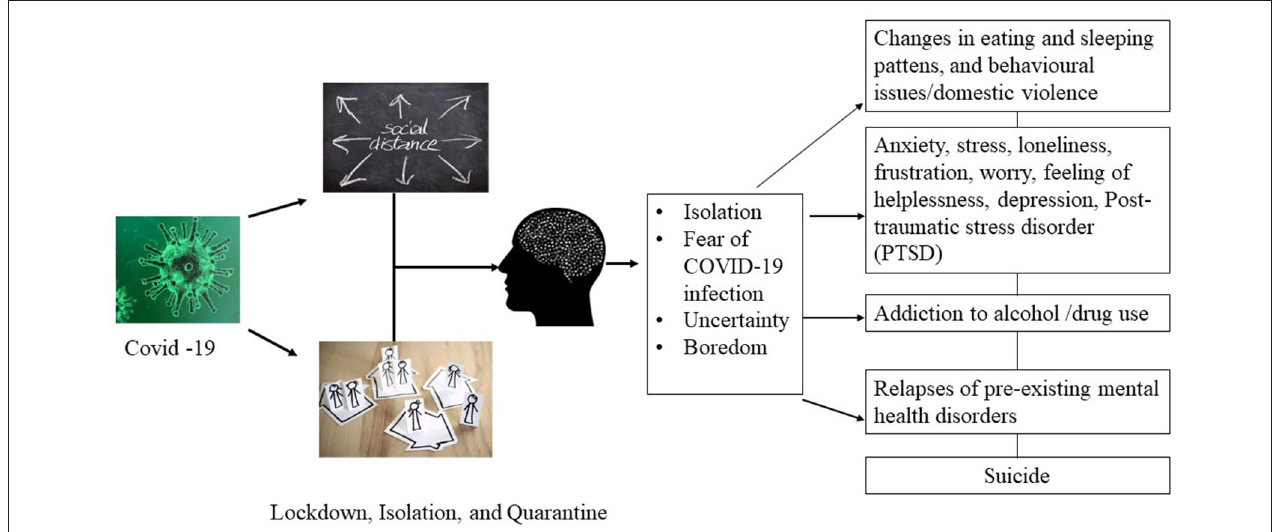
FIGURE 1 | Overview of COVID-19 impact on mental